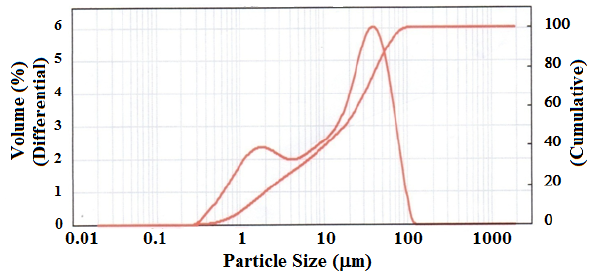
Figure 4: Particle size distribution of LF.